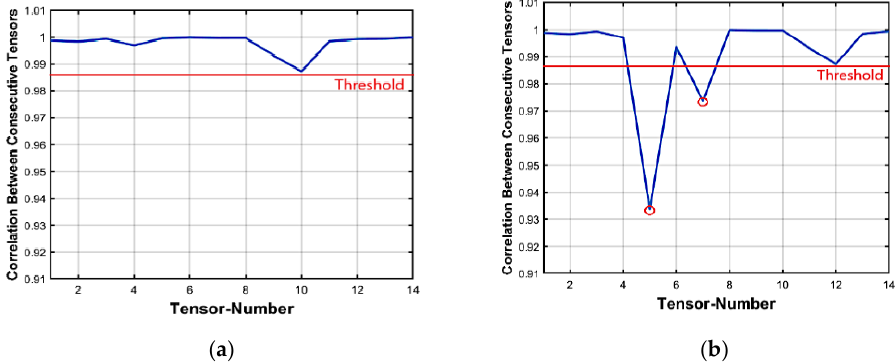
Figure 3. Inter-tensor correlation distribution analysis. ( a ) Original video Inter-tensor correlation distribution and ( b ) Forged video Inter-tensor correlation distribution (Insertion attack).